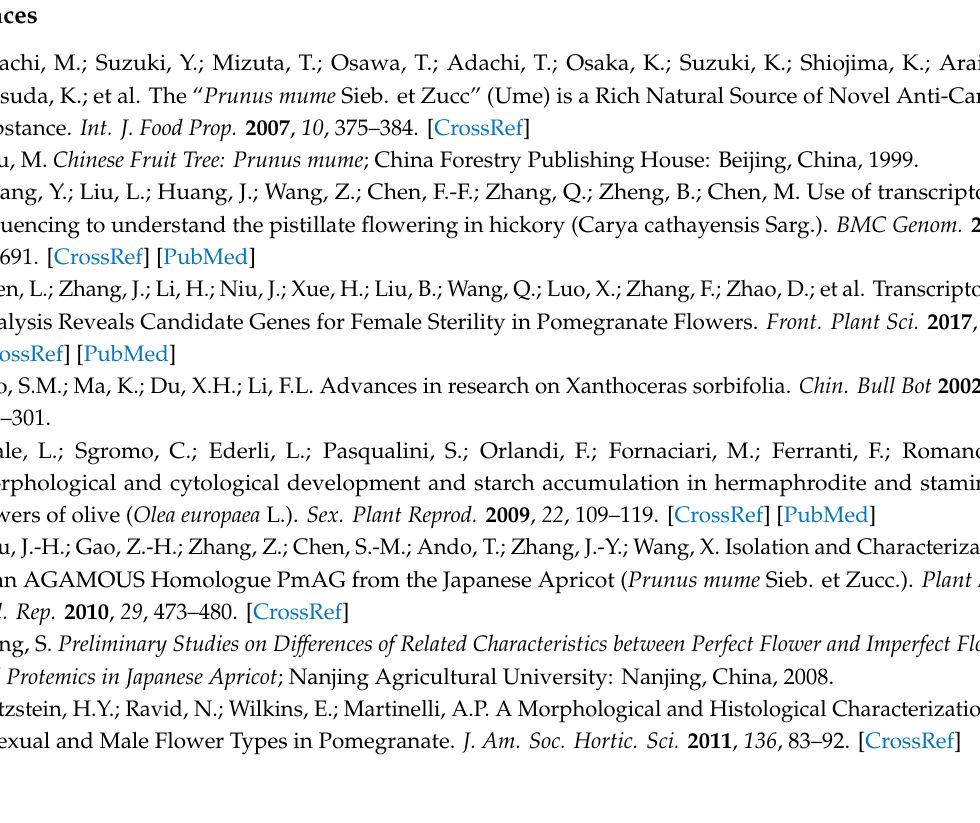
Figure S1: An overview of the present study (A) The overall experimental design process (B) The route map and analysis for RNA-Seq data, Figure S2: Expression analysis of the DEGs related to di ff erent metabolic pathways involved in this study, File S1: Total number of di ff erentially expressed genes in this study, File S2: Significantly enriched pathways and their DEGs identified in this study, File S3: Number of DEGs and their expression involved in the plant hormone signaling transduction pathway, File S4: Number of DEGs and their expression involved in di ff erent metabolic pathways, File S5: Primers used for